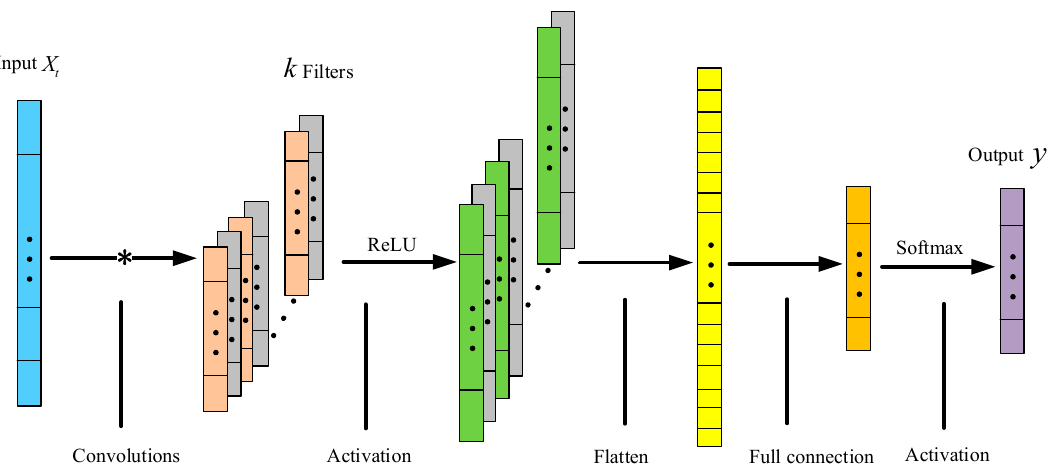
Figure 4. Schematic of one-dimensional convolutional neural network (CNN).